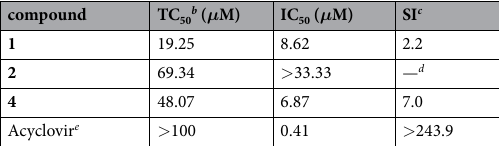
Table 4. Antiviral activity against HSV-1 and cytotoxicity for compounds 1, 2 , and 4 in Vero cells a . a Data represent mean values for three independent determinations; b Cytotoxic concentration required to inhibit Vero cell growth by 50%; c Selectivity index value equaled TC 50 /IC 50 ; d The selectivity index (SI) could not be determined under the test conditions; e Positive